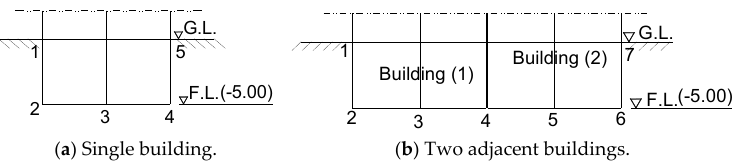
Figure 4. Points distributed around the foundations of the single and two adjacent buildings.